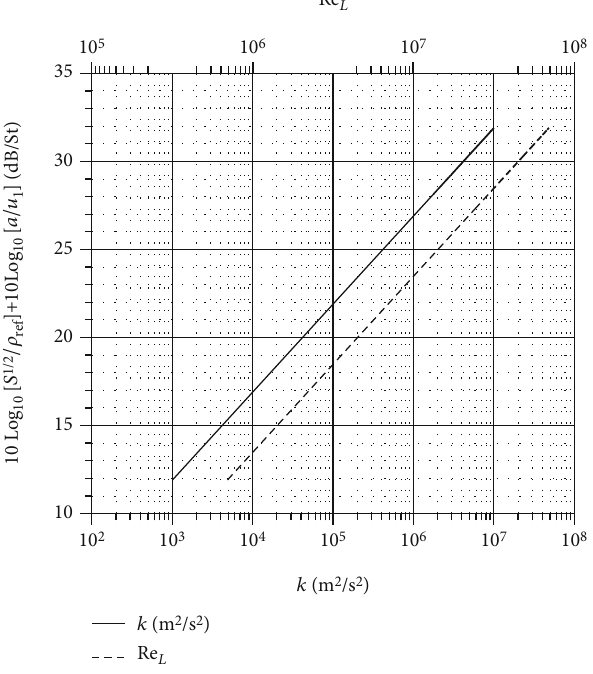
Figure 4: The power spectrum of density outside the region of isotropic turbulence at x = 1/ a relative to the integral Reynolds number and the turbulent kinetic